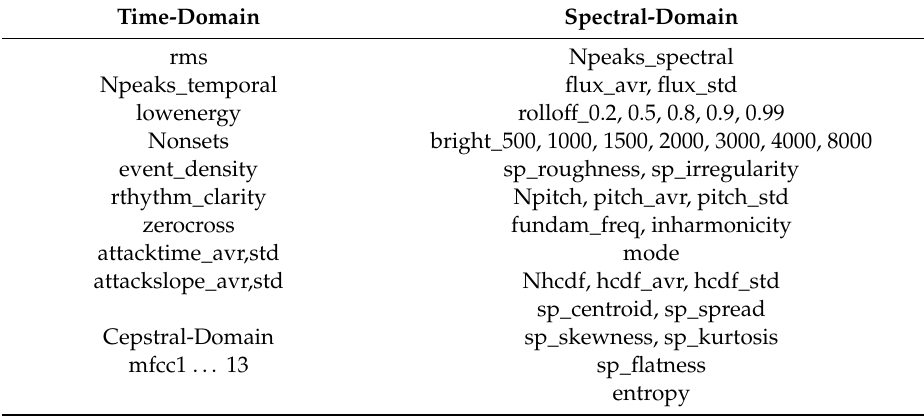
Table 2. Extracted Audio Properties (Features) of the Windowed